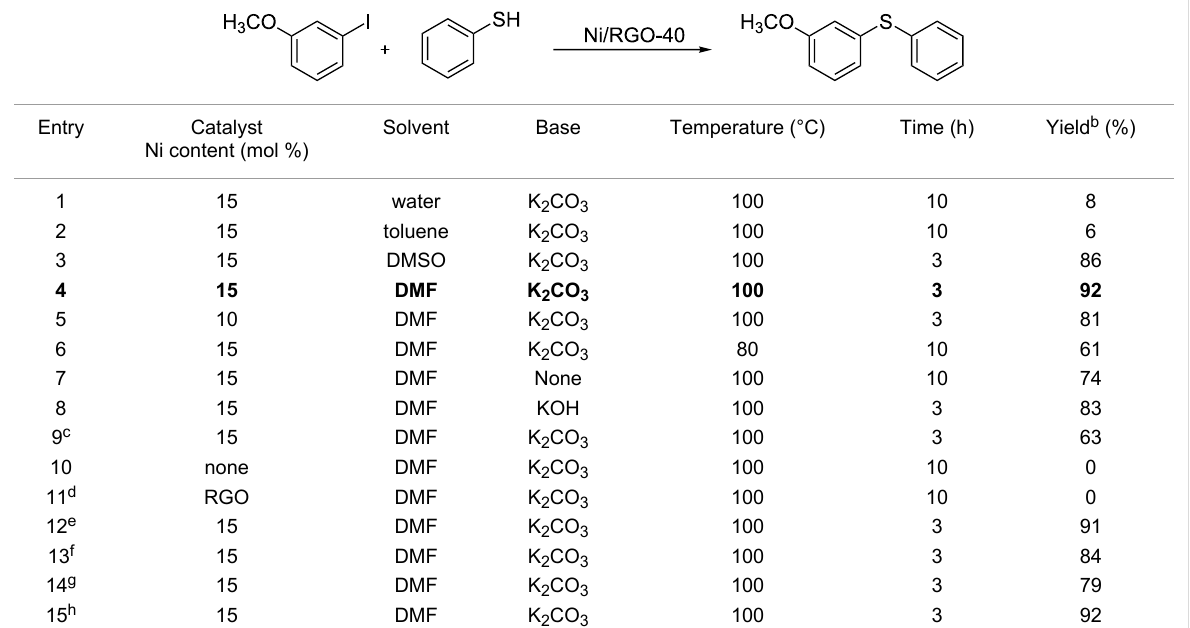
Table 1: Optimization of the C–S cross-coupling reaction conditions using Ni/RGO-40.